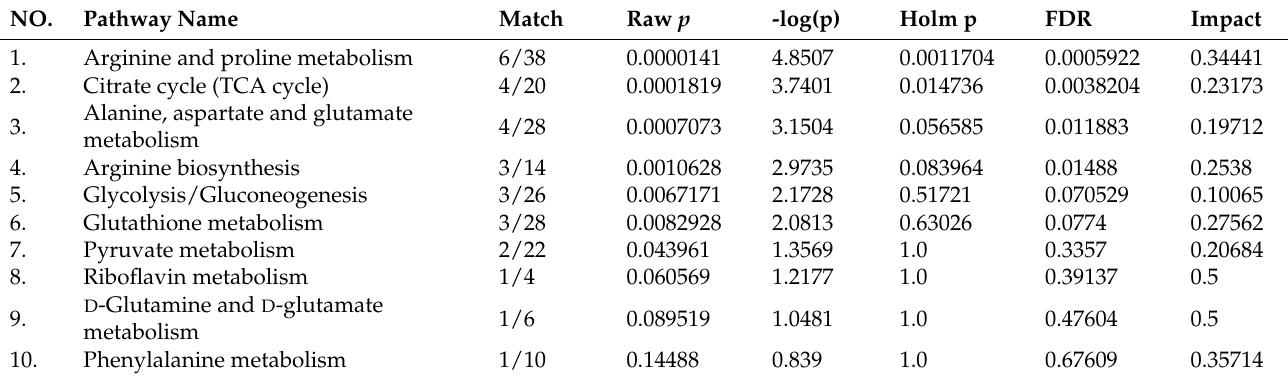
Table 2. Results of the ingenuity pathway analysis of uninfected RBCs treated with AG by using MetaboAnalyst (MetPA) shown the impact values.